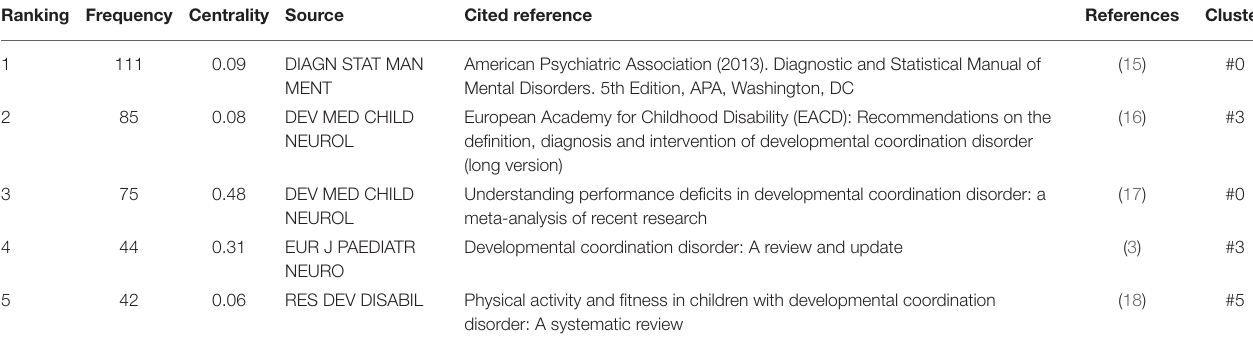
TABLE 5 | Top five co-citation references related to children with DCD,